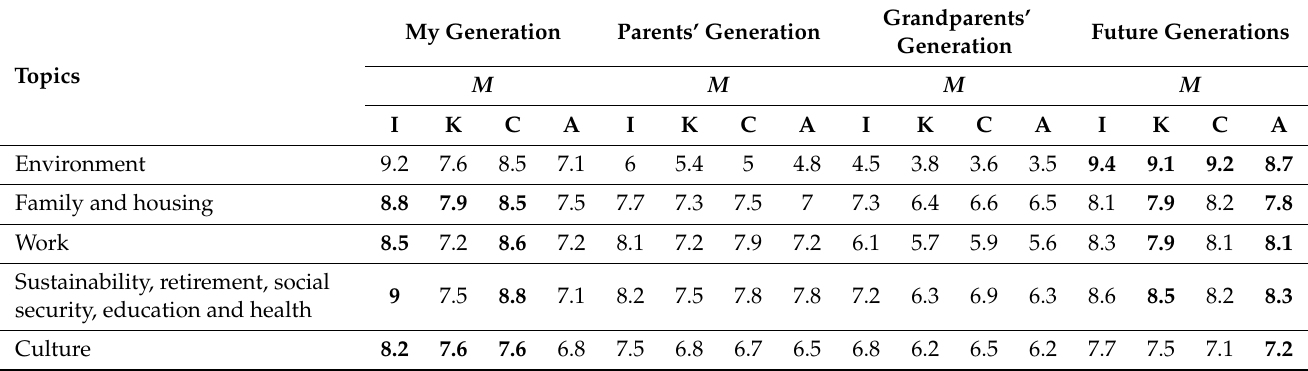
Table 1. Means of importance, knowledge, concern, and action